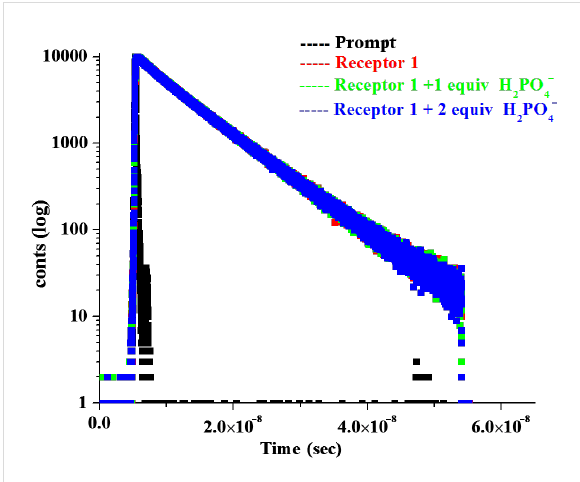
Figure 13: Fluorescence decays (at λ max = 420 nm) of receptor 1 upon the addition of H 2 PO 4 − ion ([ H ] = 5.78 × 10 − 5 M, [ G ] = 4.33 × 10 − 3 M) in CH 3 CN solvent.